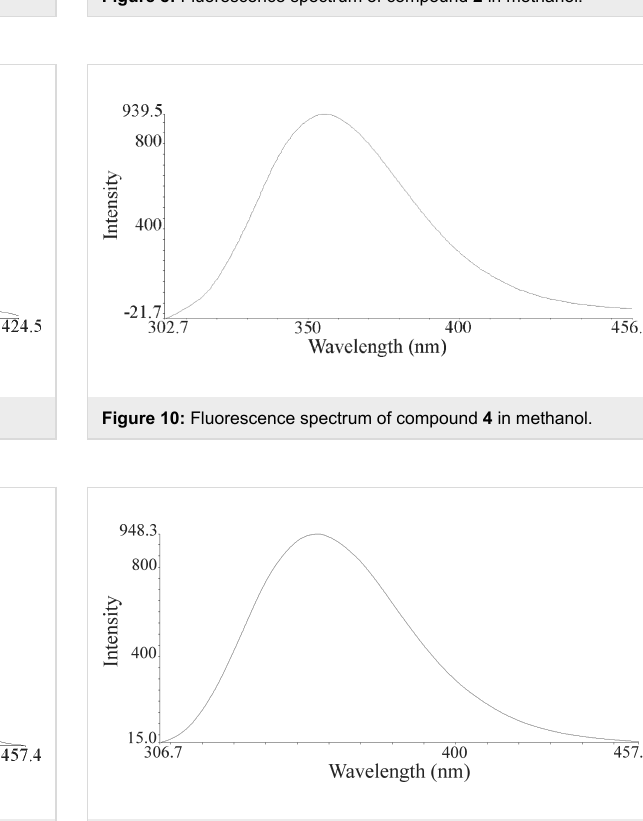
Figure 8: Fluorescence spectrum of compound 2 in methanol.